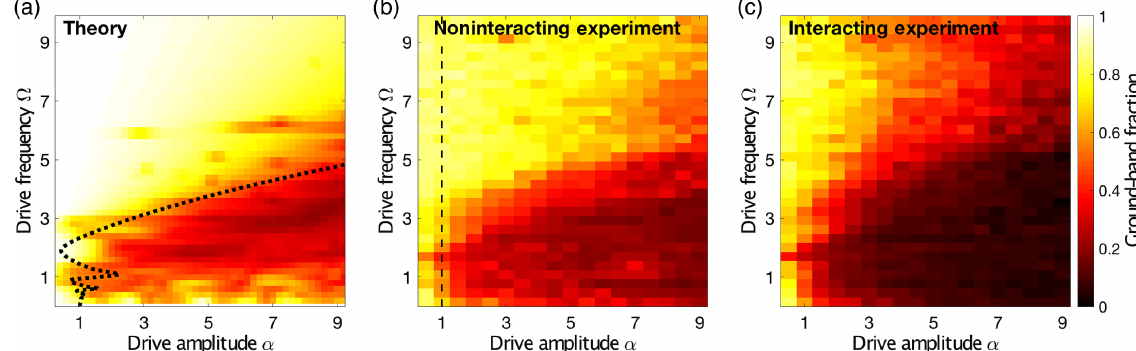
FIG. 1. Mapping the prethermal state in the space of drive parameters. (a) Theoretical map of the projected static ground-band occupation fraction for a noninteracting periodic Gibbs ensemble, as a function of normalized drive frequency Ω and normalized drive amplitude α . Dotted line shows classical stability boundary of the equivalent driven pendulum. (b) Experimental measurement of normalized population in the center of the lowest band after a 500 - μ s hold of a noninteracting quantum gas in a modulated optical lattice, as a function of the same parameters. The α > 1 region to the right of the vertical dashed line is inaccessible without the sign-changing amplitude modulation introduced in this work. (c) Same measurement as (b) but in the presence of interatomic interactions ( s -wave scattering length 30 nm). Color bar and axes are the same for all three